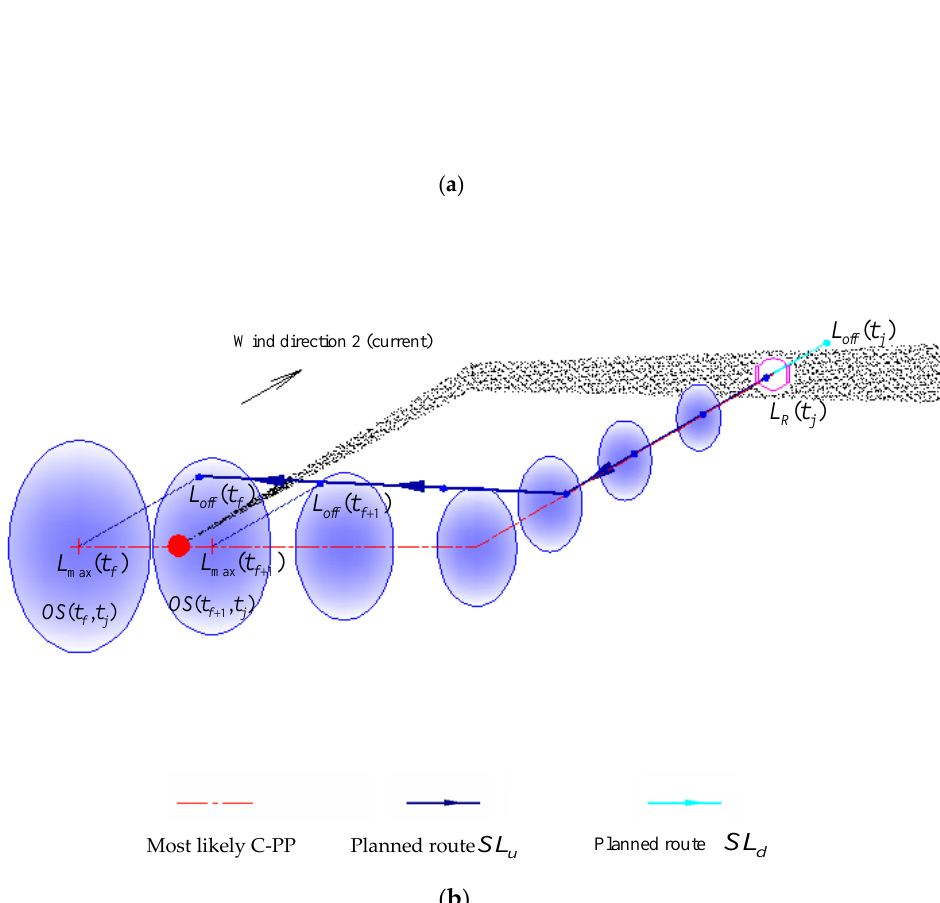
Figure 1. Chemical-source localization by following the online planned route. The planned route is represented by two colors, i.e., blue-black and cyan, corresponding to the two different parts SL u and SL d , respectively. The wind initially blows from left to right (marked with “Direction 1”) for a period in ( a ), and then changes by about 30 degrees (marked with “Direction 2”) for another period in ( b ). It is assumed that the wind is uniform throughout the planar space around the robot during each period (See 4.1 for more details). All chemical patches previously released from the chemical source therefore form the plume shown by the gray strip. The chemical patches in ( a ) are collectively transported in wind direction 2 in ( b ). When a chemical-detection event happens in ( b ), a C-PP, i.e., the ensemble of (cid:110) (cid:111) OS ( t l , t j ) , l = f , f + 1, . . . , j − 1 the elliptic areas , is estimated, and then a search route is planned online to make the robot attempt to re-meet the chemical clue. The robot will finally approach the source through an iterative searching procedure.